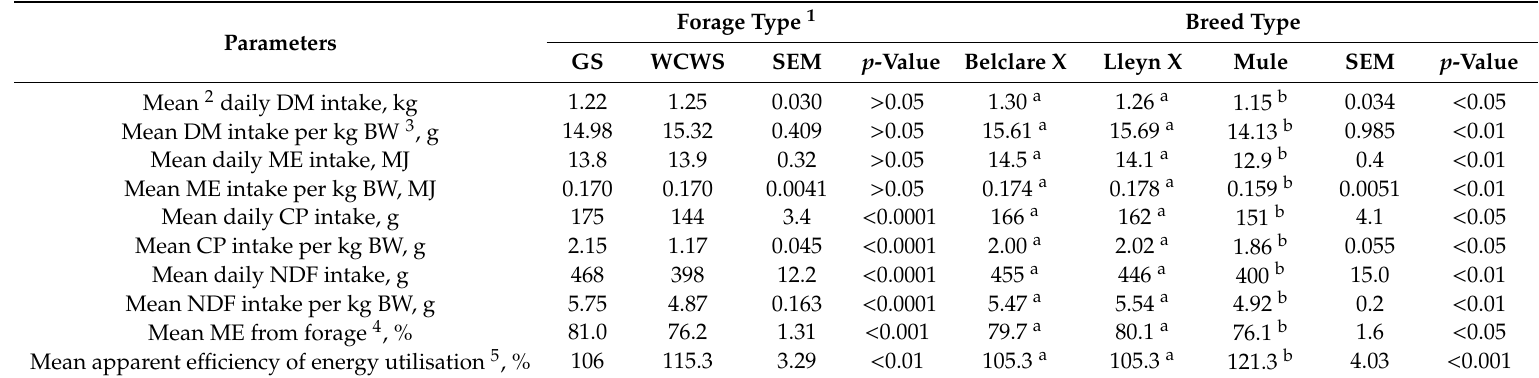
Table 2. The e ff ect of forage type and breed type on ewe average daily dry matter (DM), metabolisable energy (ME), crude protein (CP), neutral detergent fibre (NDF) intake, and apparent e ffi ciency of energy utilisation (least square means ±